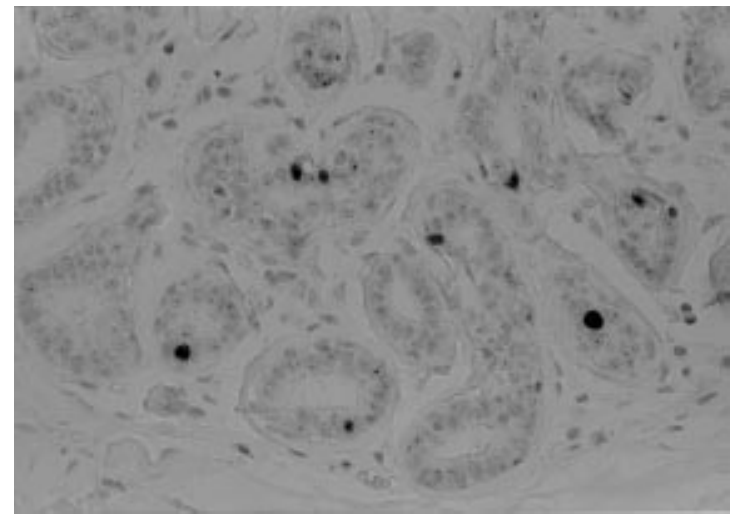
Fig. 3. MIB1 immunoreactivity in normal breast epithelium ( (cid:2)